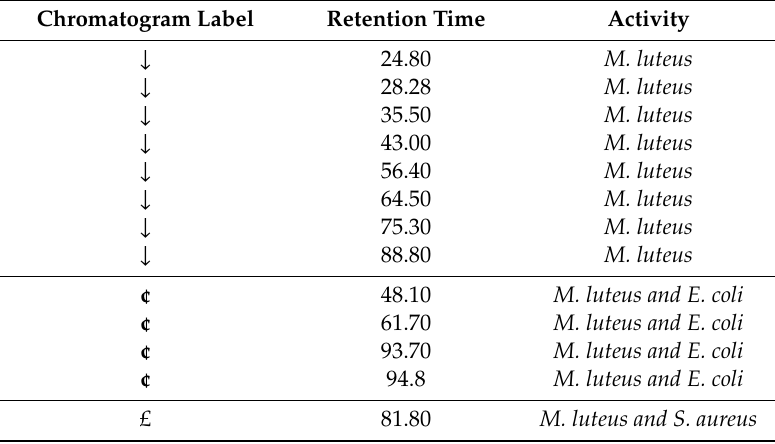
Table 1. Antimicrobial results of the HPLC-selected fractions. The highlighted fractions obtained through HPLC with their respectively retention time and antimicrobial activity.